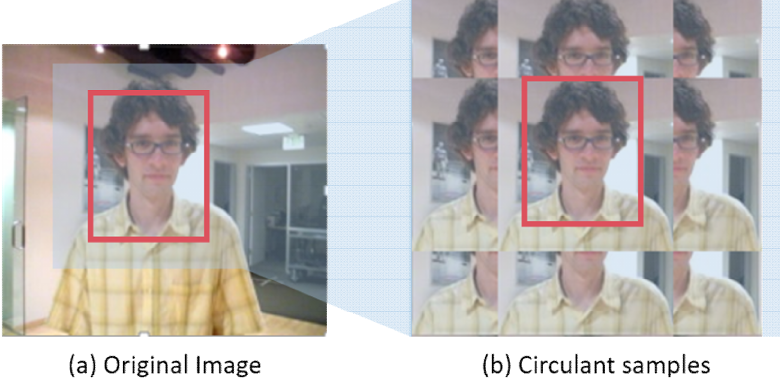
Figure 1. Image ( b ) shows the circulant samples obtained by DCF methods from original image ( a ), leading to a limited range of features for the filter to be learnt from. As a consequence, the template learnt is not discriminative enough.